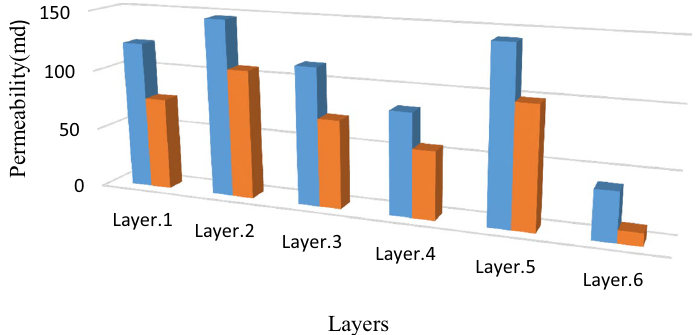
Fig. 7 Comparison of perme- ability between two techniques